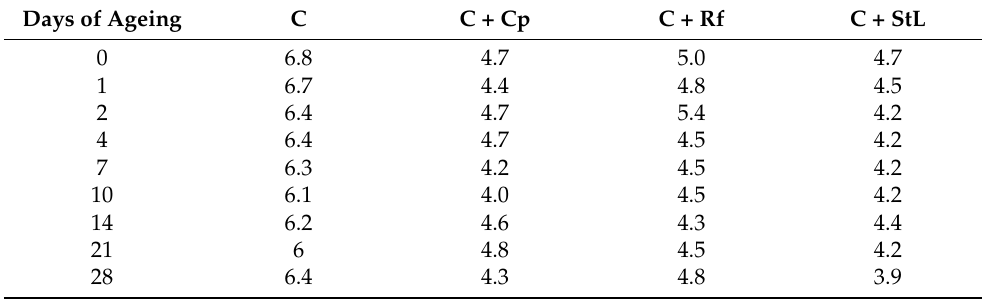
Figure 8. Graph showing the changes of tensile strength of all sets of mock-ups at all ageing stages.